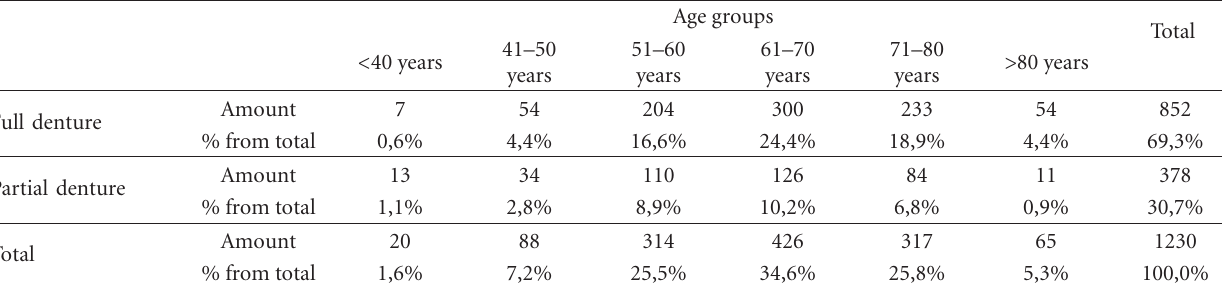
Table 4: The numbers of denture users in groups of